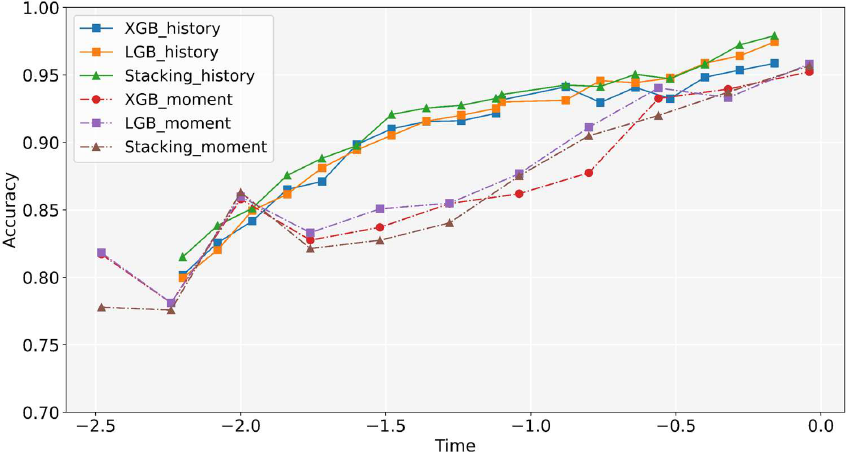
Figure 18. Comparison of lane-changing intention recognition accuracy based on a single time and historical time window. historical time